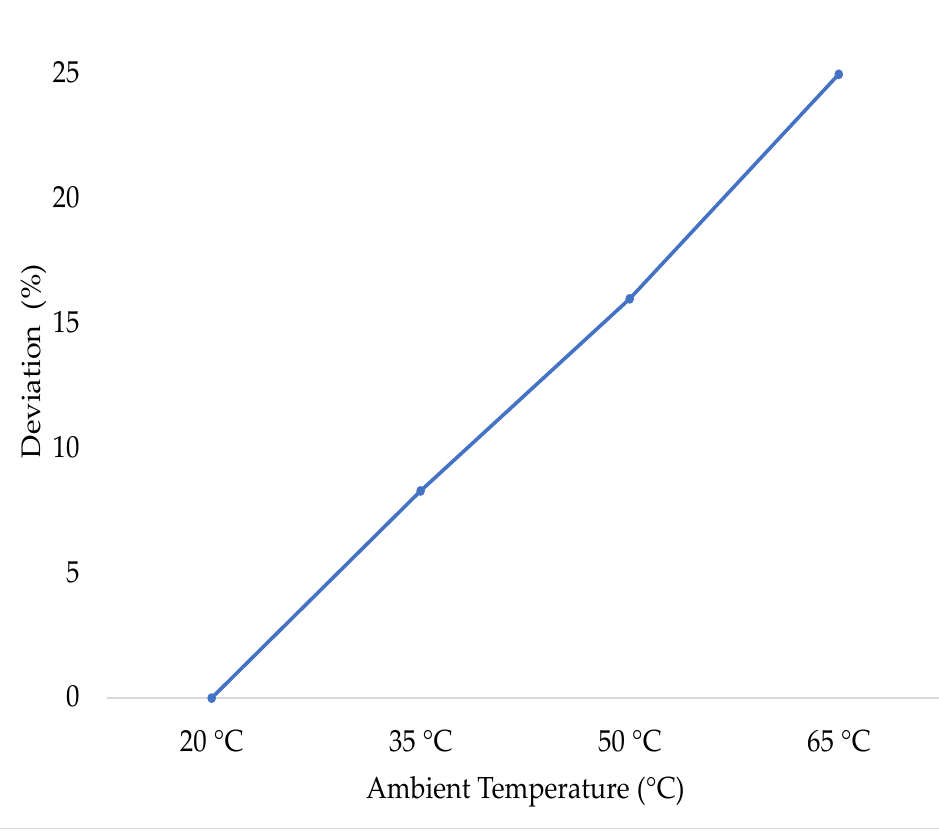
Figure 14. ψ PM tracking error in Wb against the reference at a nominal temperature of 20 ◦